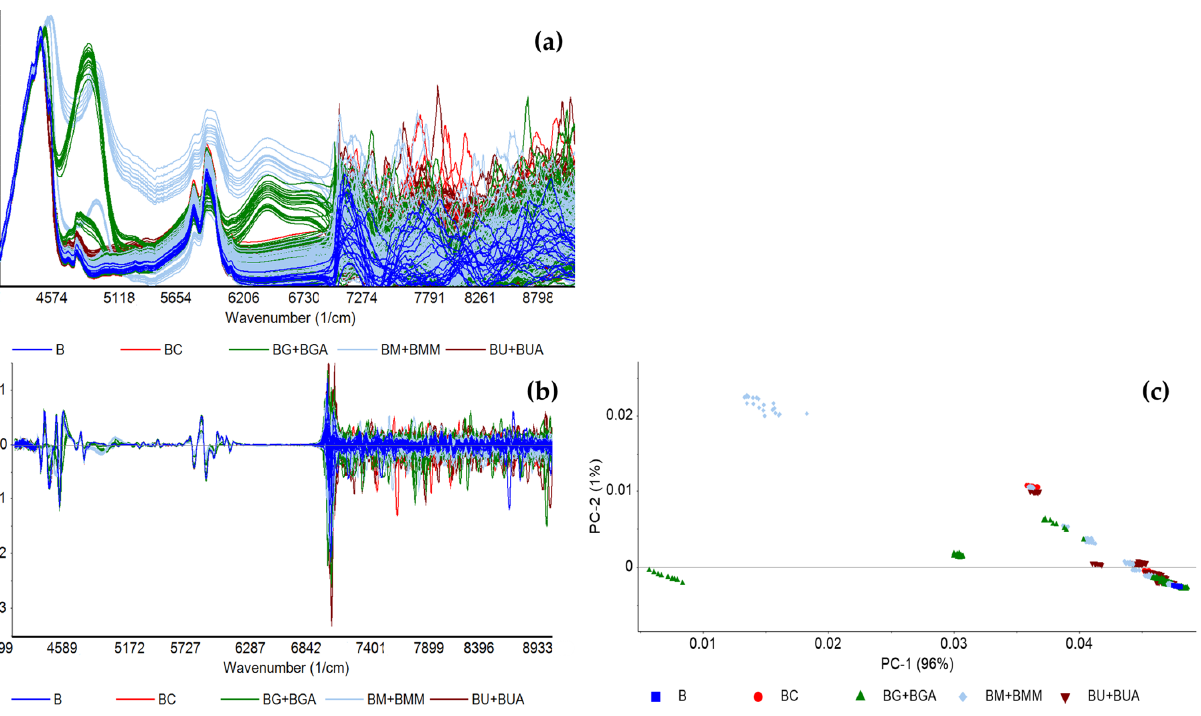
preprocessing: unprocessed (None), mean centering (MC), baseline correction (Base corr), and 2nd order derivative (SV2).